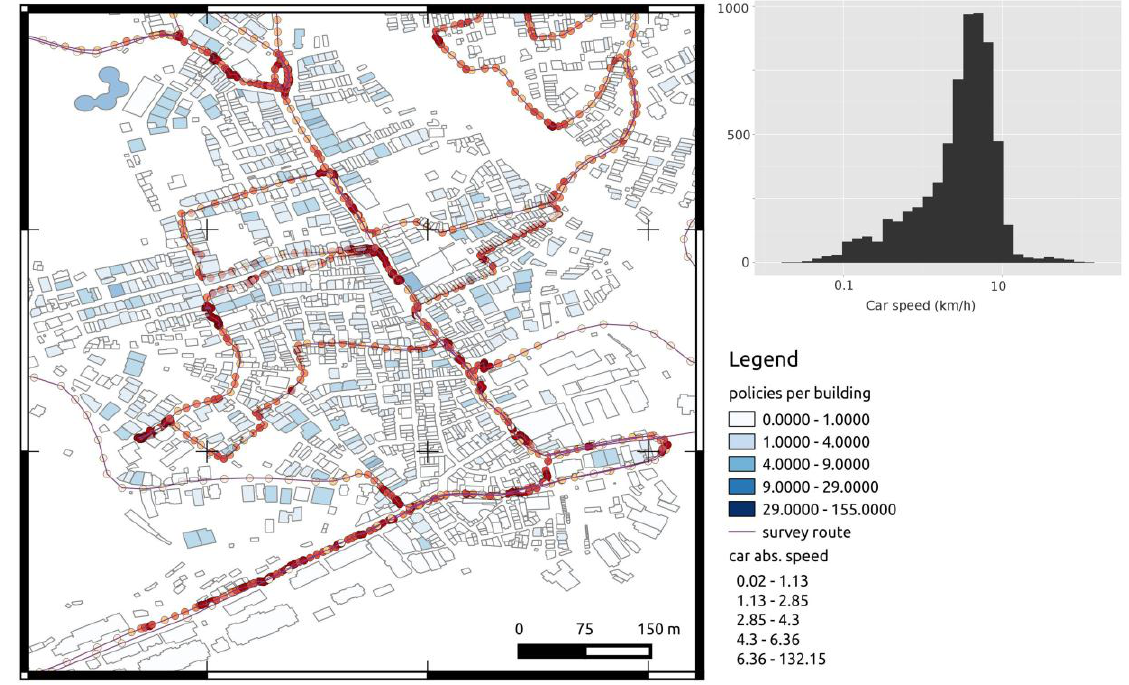
Figure 10. The color of the trace is proportional to the absolute speed of the mobile mapping system ( left) . Distribution of the speed during the survey (logarithmic scale) in Km/h ( right)